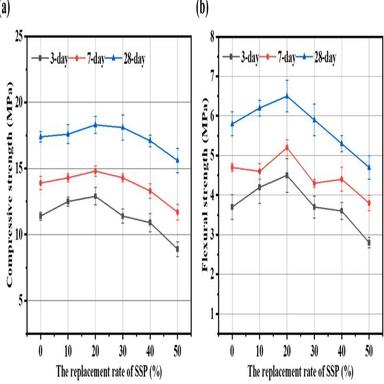
Strength development of mortar with different SS content: (a) Compressive strength of mortar with different SS content; (b) Flexural strength of mortar with different SS content.